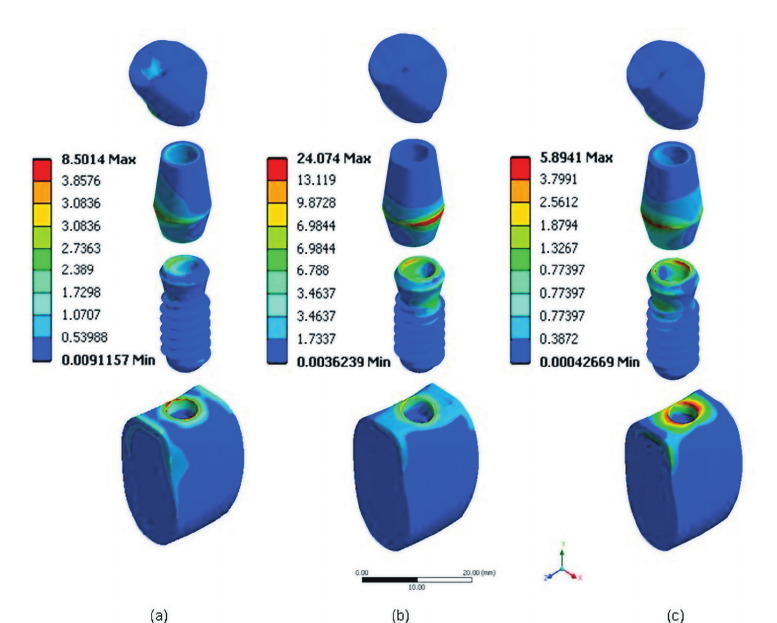
Figure 5- Von Mises stress levels in the conventional implant model components under different load cases. (a) Corono- apical load, (b) Linguo-buccal load, (c) Disto-mesial load